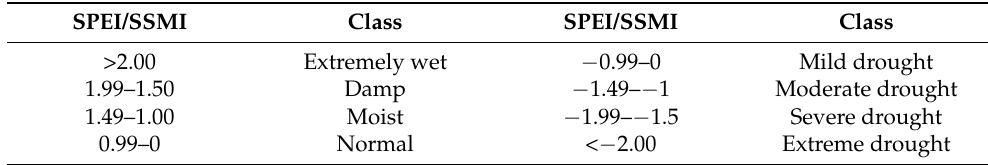
Table 1. Classification schemes of the SPEI and